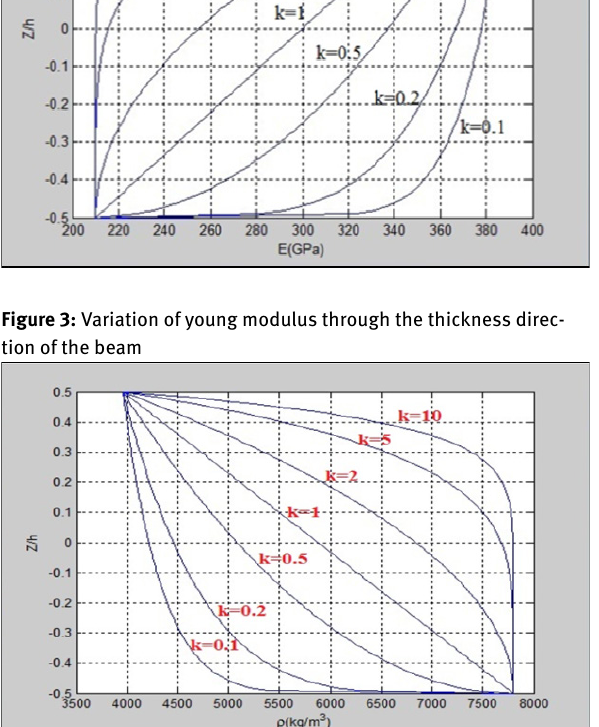
Figure 4: Variation of mass density through the thickness direction of the